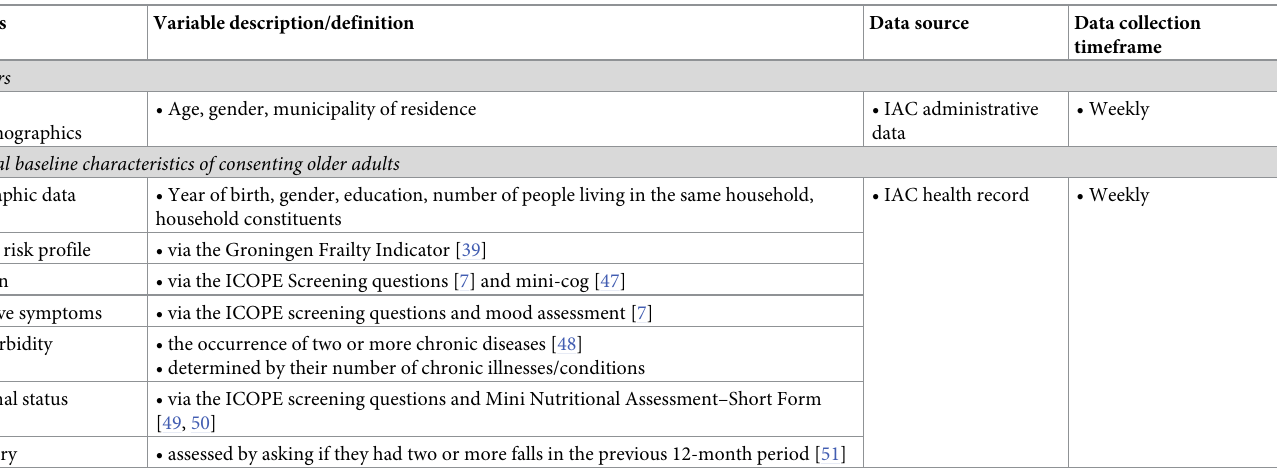
Table 4. Baseline characteristics of all visitors and consenting older